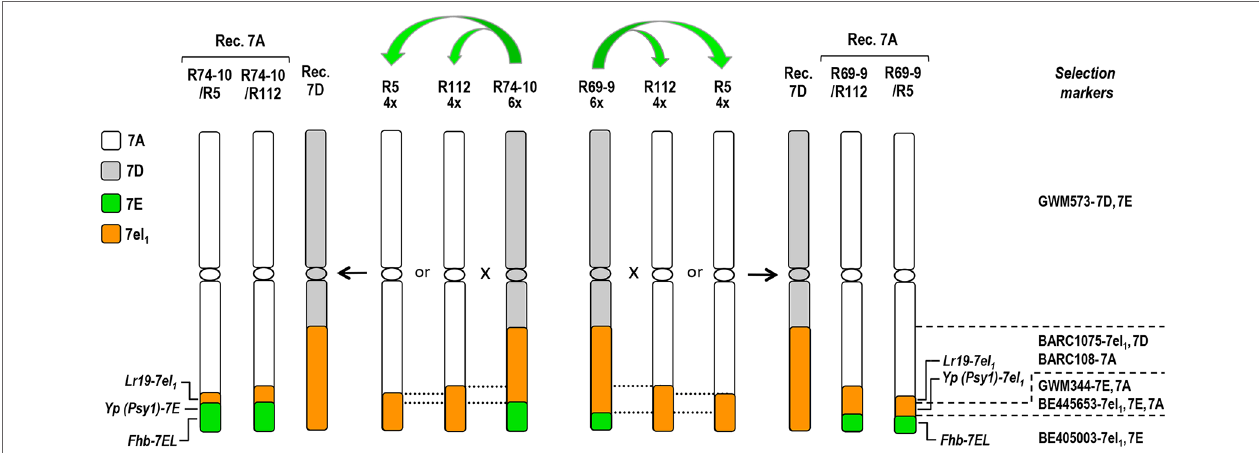
FIGURE 1 | Cytogenetic maps of group-7 wheat- Thinopyrum spp. chromosomes involved in the pyramiding scheme of distal 7EL segments carrying the Fhb-7EL QTL (from 6x lines R69-9 or R74-10) into 7el 1 L-7AL arms of 4x lines R112 or R5. Dotted lines delimit the regions where homologous pairing and crossing-over in the shared 7el 1 L regions can occur and give rise to the desired pyramiding. Dashed lines on the right indicate the chromosomal regions where marker loci and target genes are located. For detailed genetic and physical mapping data of Thinopyrum spp. segments into wheat chromosomes, see Ceoloni et al.,